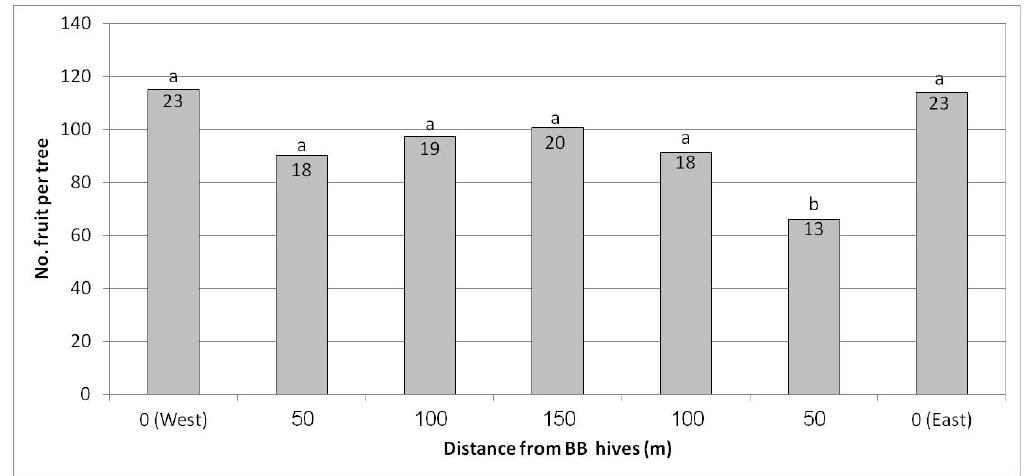
Figure 9. Effect of adding bumblebee (BB) hives (April 2019) to both sides of the orchard on the number of fruit per tree and kilogram of fruit per tree (no. in the column) in February 2020 at seven distances from the BB hives, Kfar Hanassi, 2019/20. Results in a column followed by different letters differ significantly according to Duncan’s new multiple range test, p < 0.05. Data are the means of 120 ‘Hass’ trees per distance (30 trees/row × 4 rows).